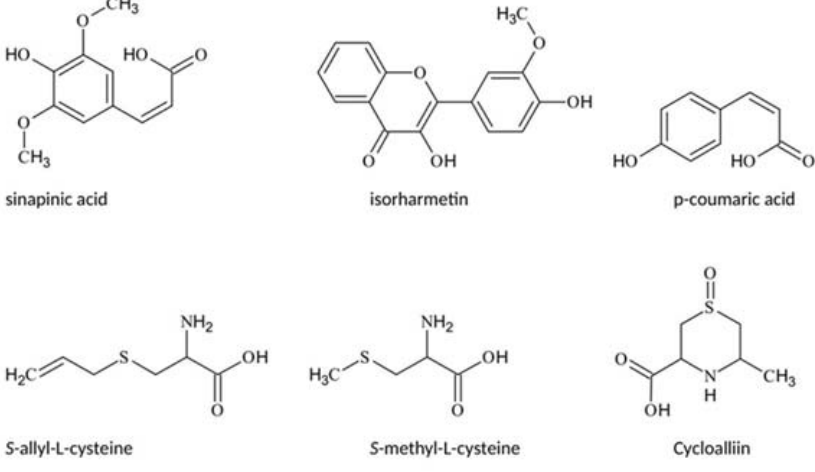
Figure 1. Structures of reference substances used for identification.